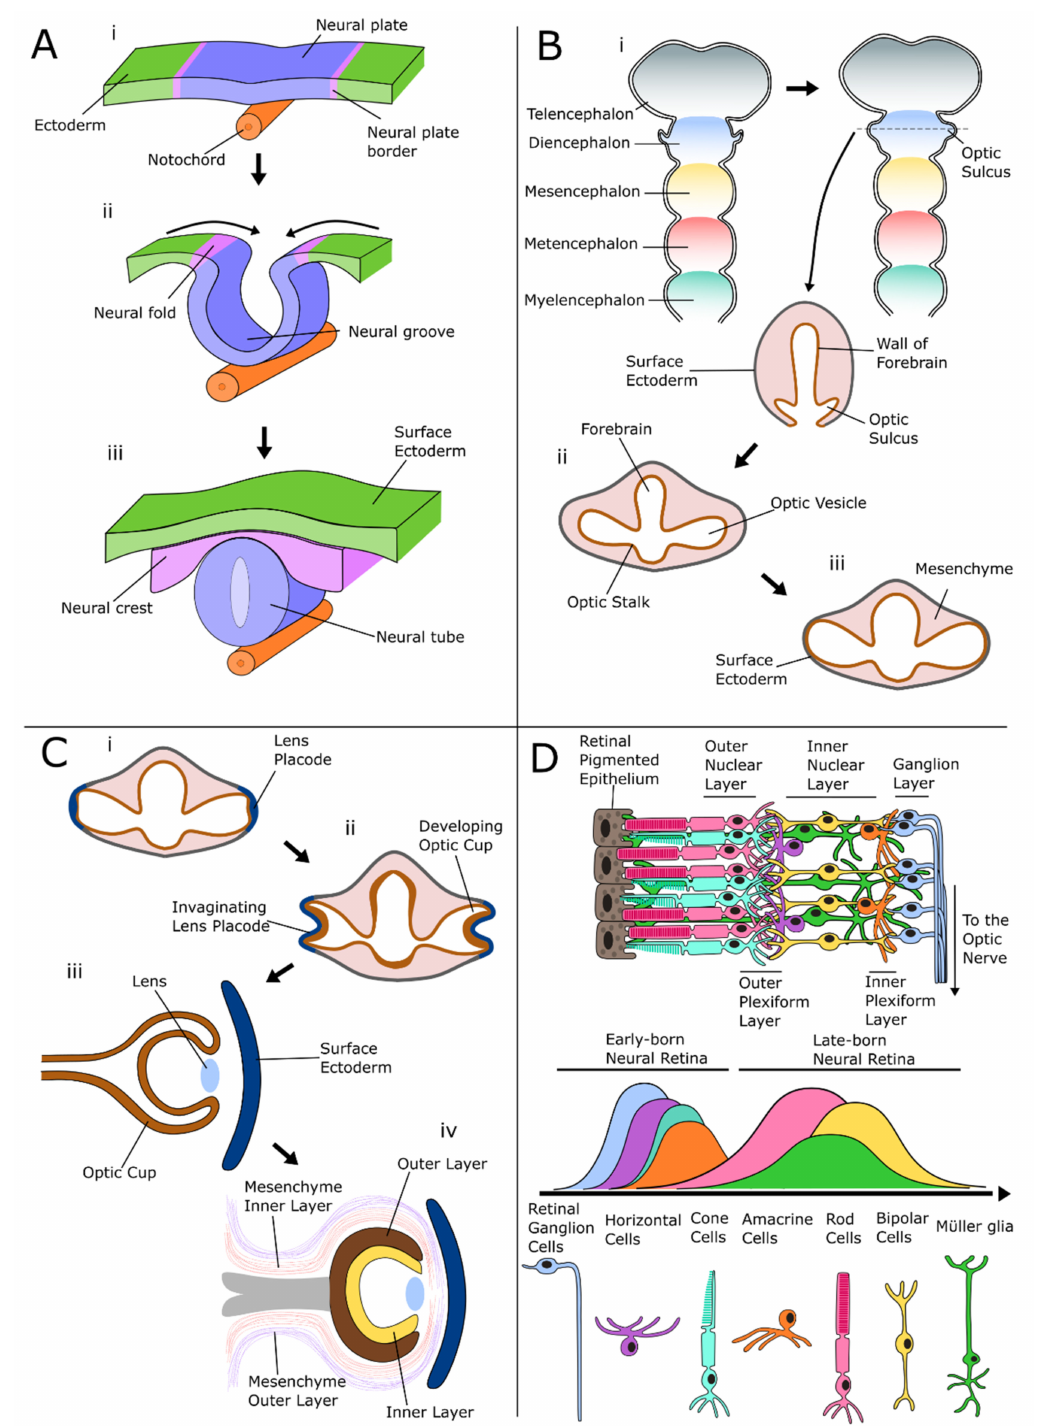
Figure 1. The phases of the embryological development of the eye. ( A ) The first stage of development is the formation of the neural tube. ( Ai ) The notochord stimulates the neural plate to be drawn inwards from the ectoderm. ( Aii , Aiii ) The neural folds meet and fuse, creating the neural tube and neural crest. ( B ) The formation of the optic vesicle. ( Bi ) The neural tube develops into five secondary vesicles. ( Bii ) The optic sulcus grows out laterally from the diencephalon, enlarging